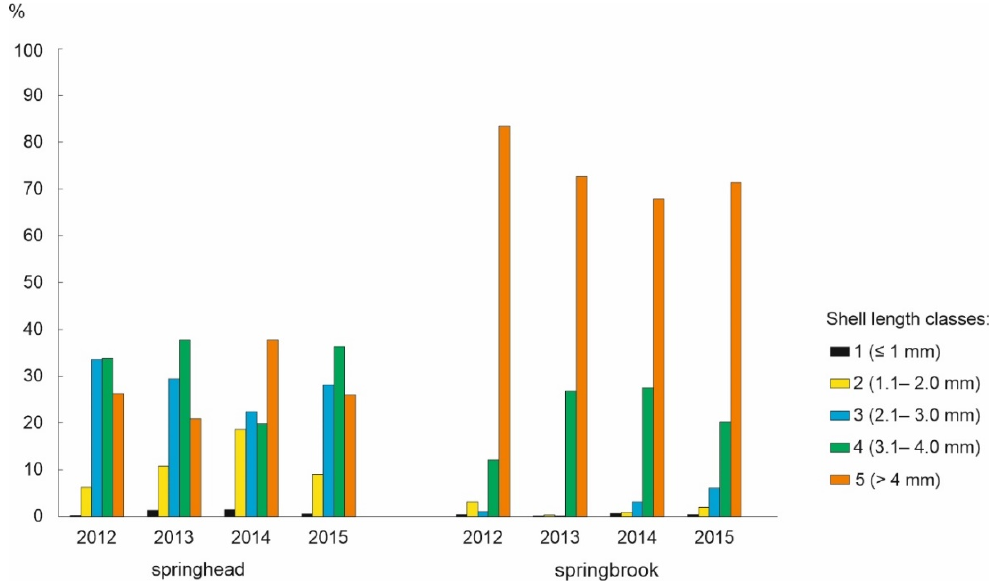
Figure 4. Size (shell length) class distribution of Potamopyrgus antipodarum at the sampling areas during the study period.